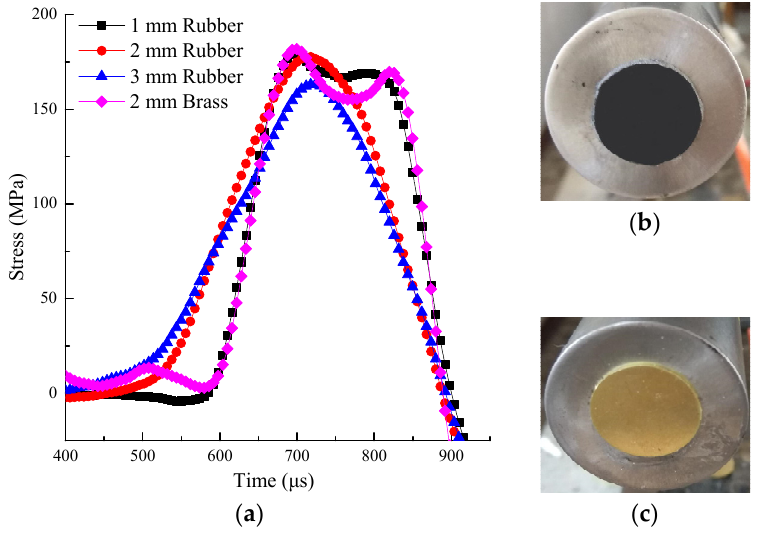
Figure 5. The waveforms of incident waves with different pulse shapers: ( a ) Stress time history curve, ( b ) Rubber sharper, ( c ) Brass sharper.